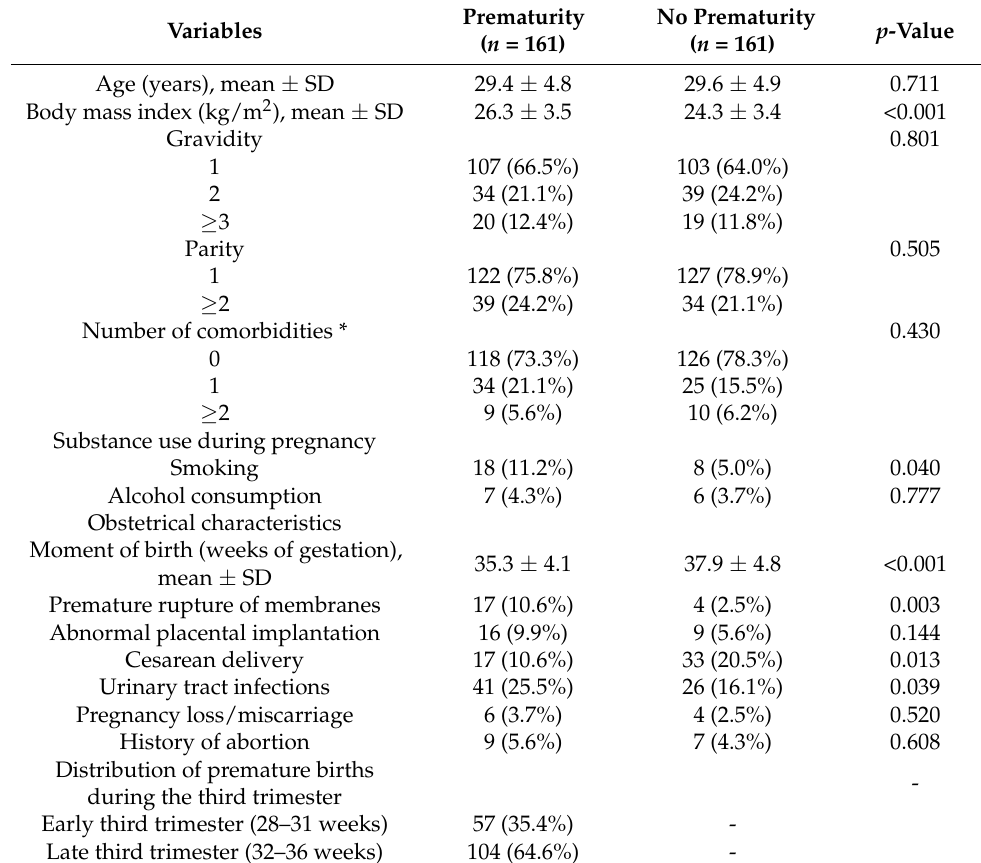
Table 1. Background characteristics of the patients analyzed in the